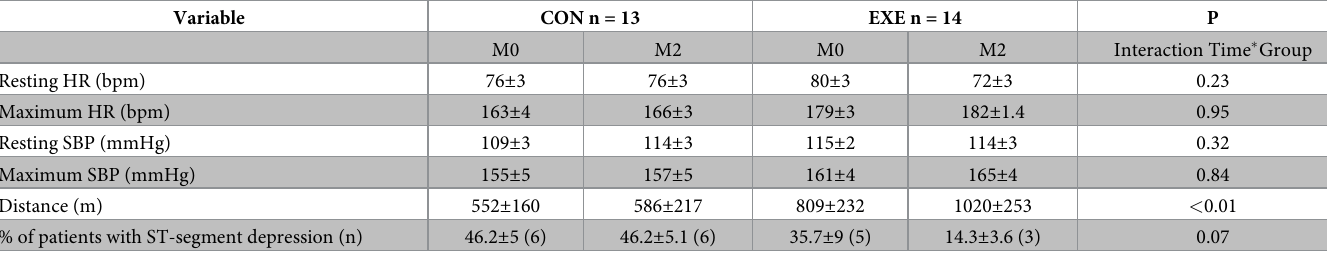
Table 2. Comparison of the variables of the ergometric test between the groups (CON and EXE) at time points M0 and M2.